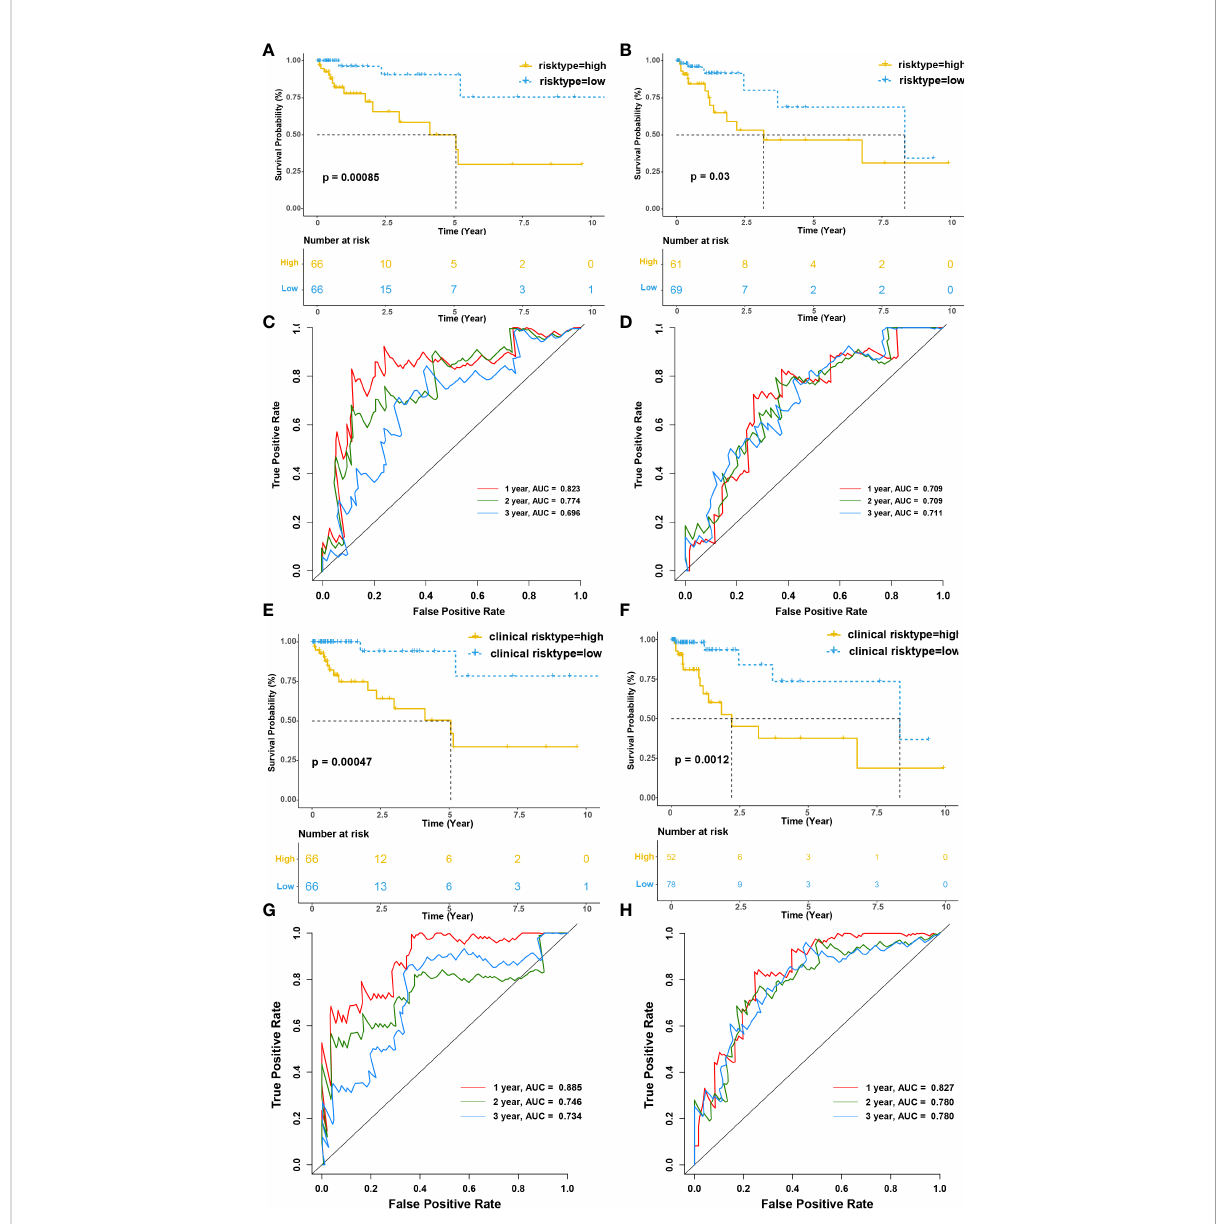
FIGURE 7 In fi ltration of tumor-educated immune cells is associated with a worse prognosis in CRC. (A, B) Kaplan – Meier survival curves of immune risk model for the training (A) and testing cohorts (B) , respectively. (C, D) The time-dependent ROC curves of immune risk model for 1-, 2- and 3- OS year in the training (C) and testing cohorts (D) , respectively. The areas under the ROC curve for 1-, 2- and 3- year OS were 0.823, 0.774, and 0.696 in the training cohort and 0.709, 0.709 and 0.711 for 1-, 2- and 3- year OS in the testing cohort. (E, F) Kaplan – Meier survival curves of clinical risk model for the training (E) and testing cohorts (F) , respectively. (G, H) The time-dependent ROC curves of clinical risk model for 1-, 2- and 3- OS year in the training (G) and testing cohorts (H) , respectively. The areas under the ROC curve for 1-, 2- and 3- year OS were 0.823, 0.774, and 0.696 in the training cohort and 0.709, 0.709 and 0.711 for 1-, 2- and 3- year OS in the testing